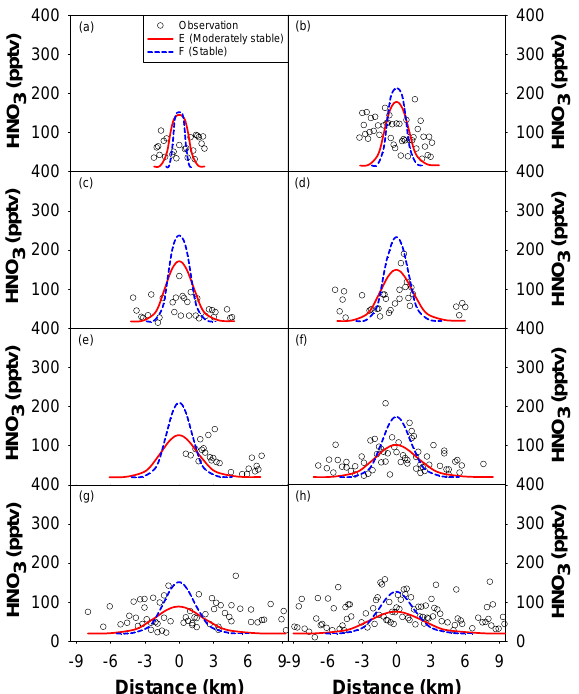
of 0.05 was used in 3 ,ss